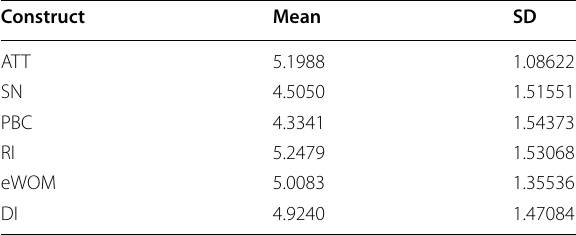
Table 3 Descriptive statistics. Source : Primary